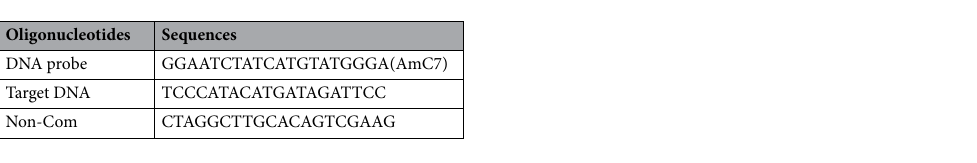
Table 3. Oligonucleotides that involved in biosensor